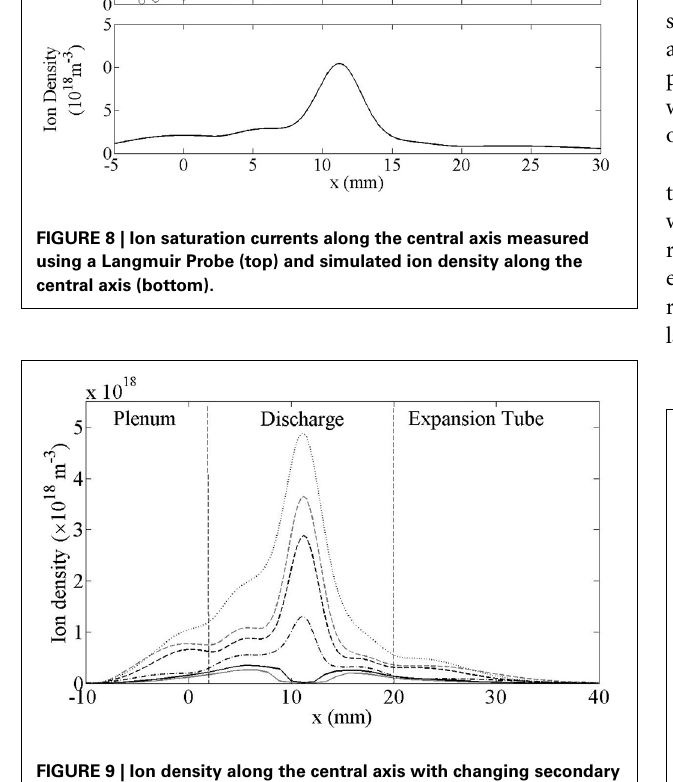
FIGURE 10 | Phase-averaged electron (dashed line) and ion (solid line) density radially across the Pocket Rocket tube, in line with the center of the rf electrode (x =